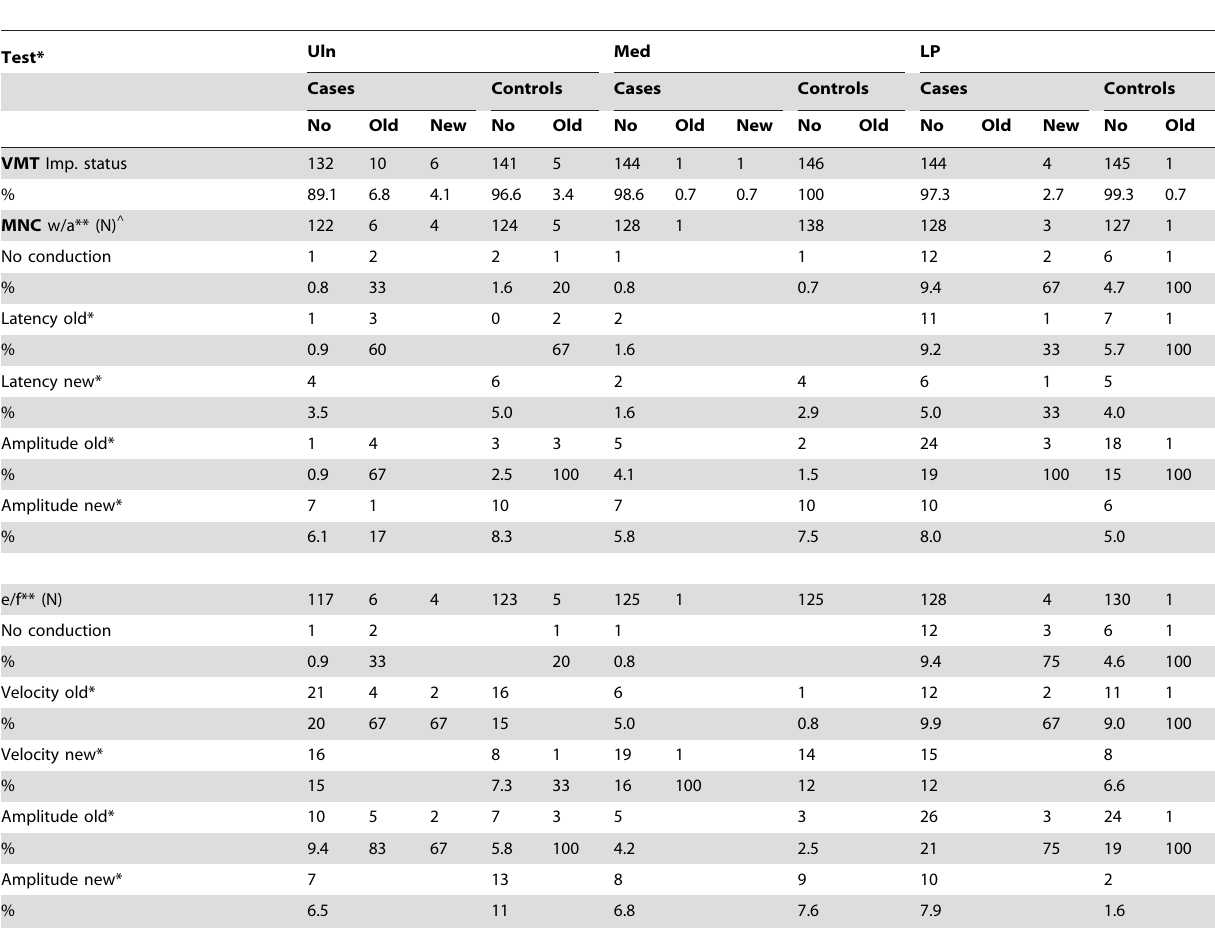
Table 4. Cross tabulation of motor impairment, compared to age and sex-specific normal thresholds, between the VMT